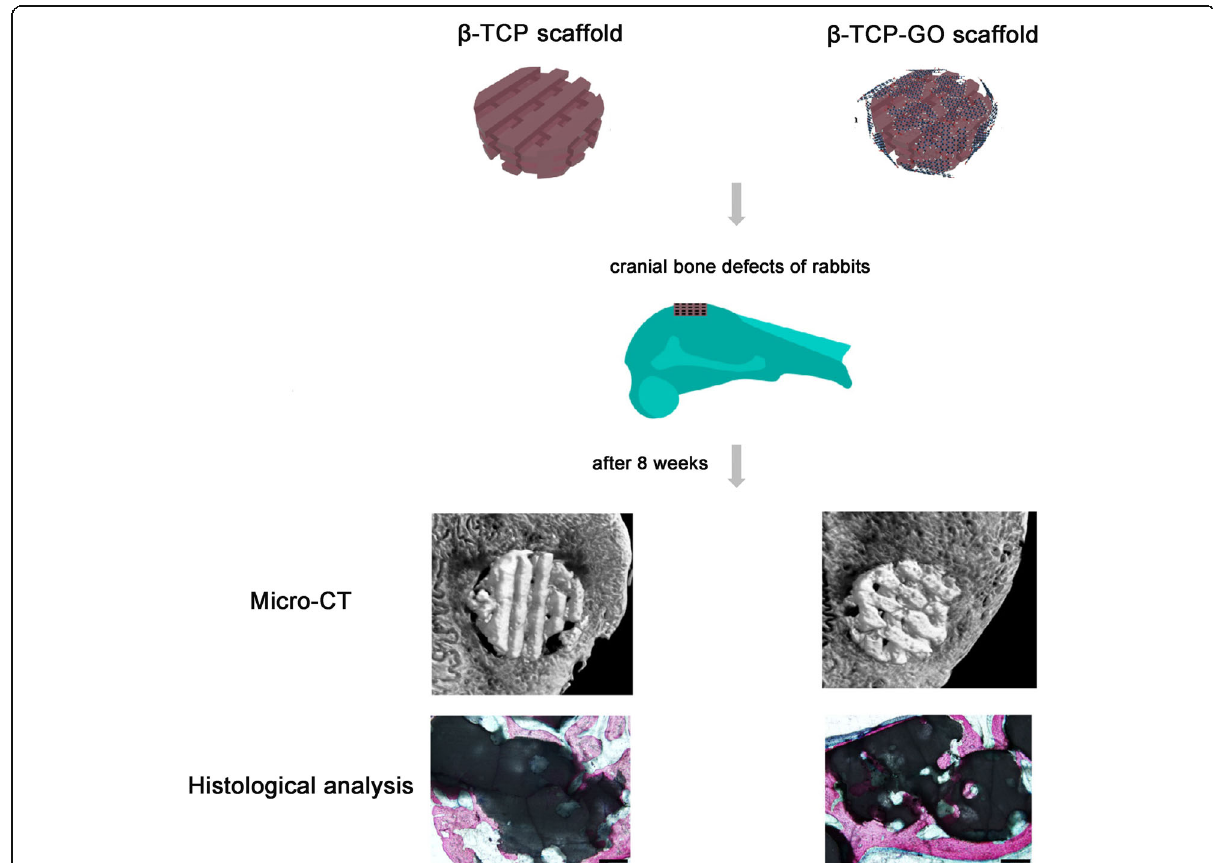
Fig. 3 Scheme illustration for β -TCP and β -TCP-GO scaffolds stimulated the in vivo osteogenesis. Micro-CT analysis and histological analysis of in vivo bone formation ability for the β -TCP and β -TCP-GO scaffolds after implanted in the cranial bone defects of rabbits for 8 weeks. Reproduced from ref. [85] with permission from the Journal of